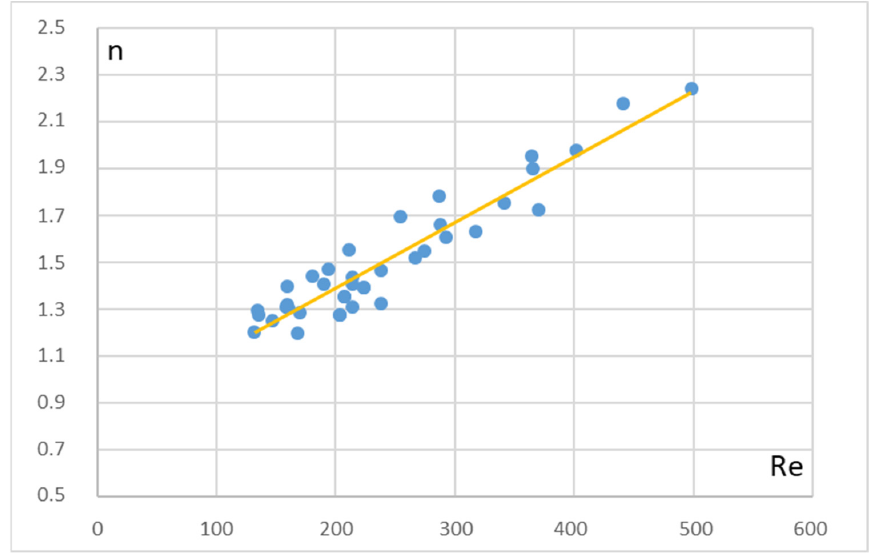
Figure 10. The function n ( Re ) for the case Ri > Ri ∗ .